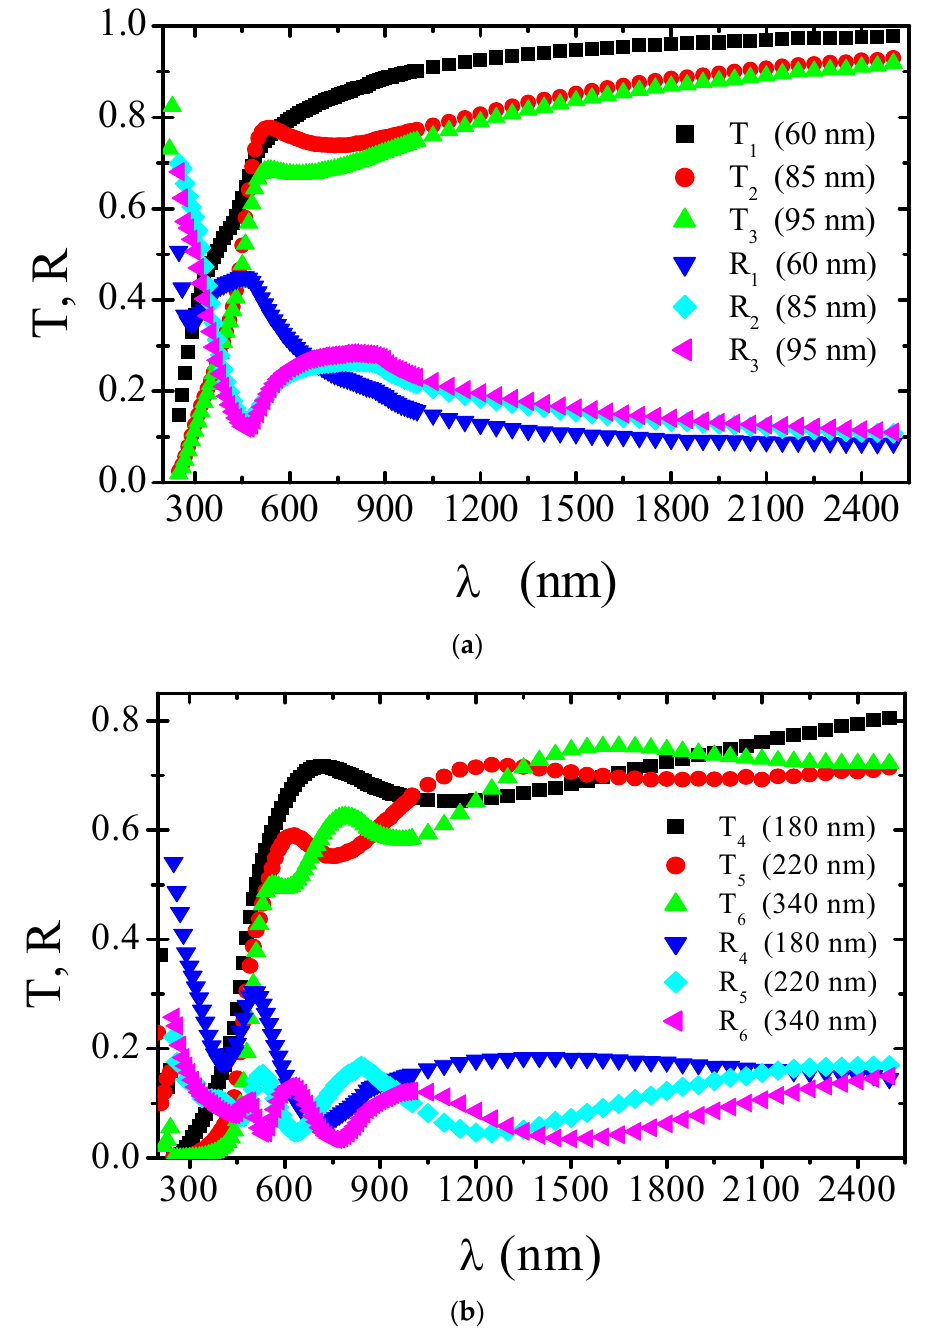
Figure 6. Transmittance and reflectance curves of ( a ) homogeneous CdS thin films. ( b ) inhomogeneous CdS thin films.